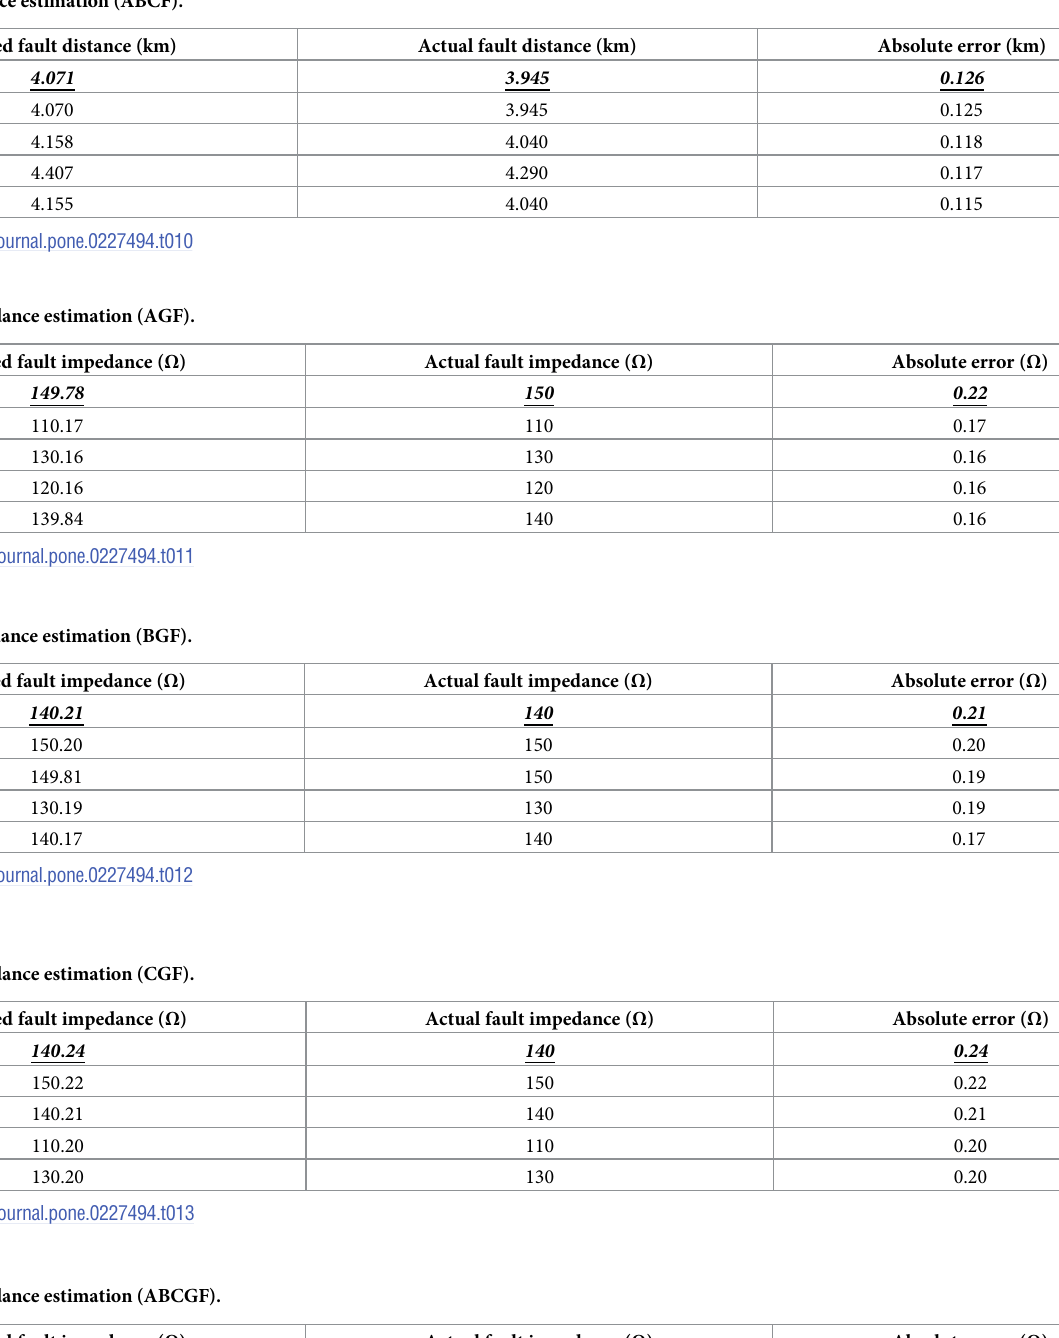
Table 10. Fault distance estimation (ABCF).